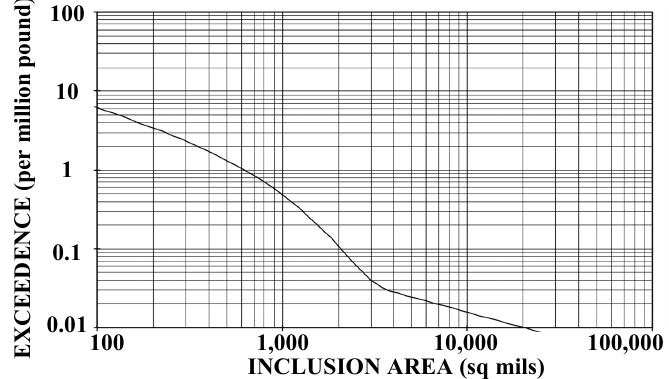
Figure 3. Initial defect distribution curve [33].